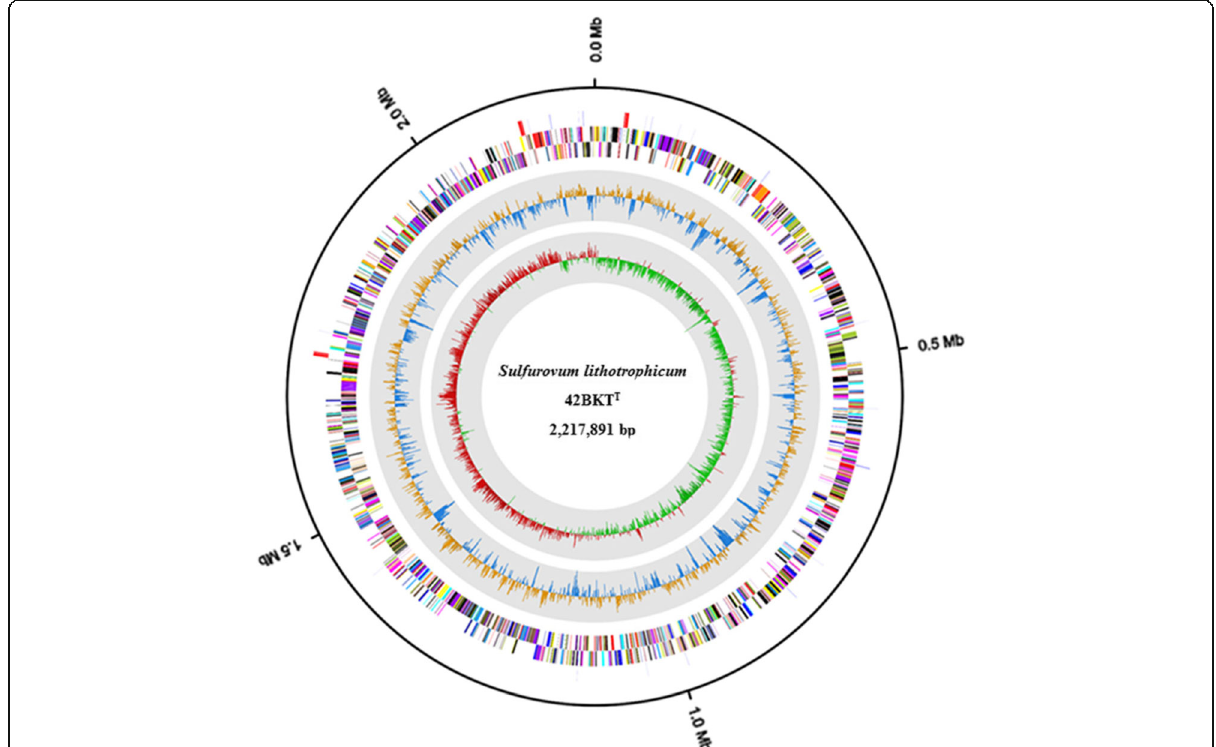
Fig. 3 Genome map of Sulfurovum lithotrophicum 42BKT T . From the outer to the inner circle: RNA regions (rRNA, red; tRNA, lavender), CDS on the reverse strand (colored based on COG categories), CDS on the forward strand (colored based on COG categories), G + C skew ( blue/goldenrod ), and GC ratio ( green / red